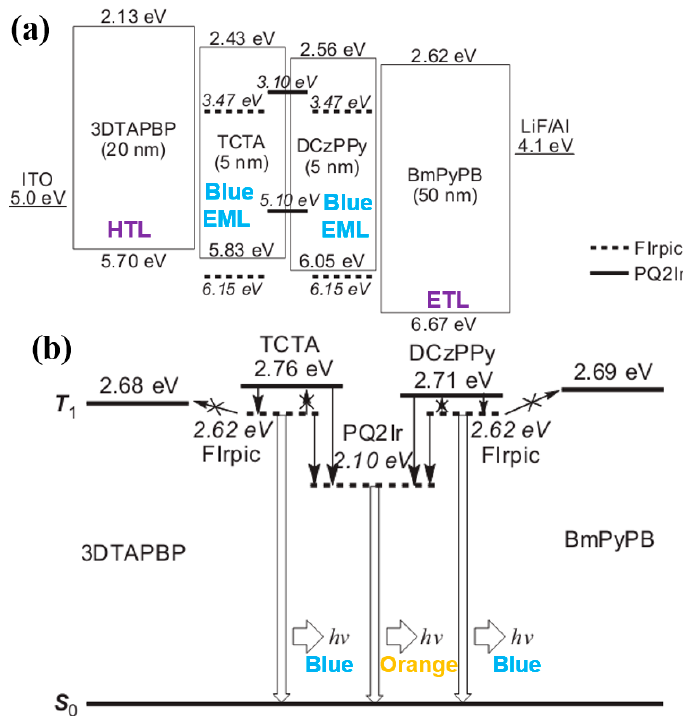
Figure 10. ( a ) The device structure of the WOLED and the proposed energy level; ( b ) Diagrams of EL processes in WOLEDs. Reproduced from Reference [133].